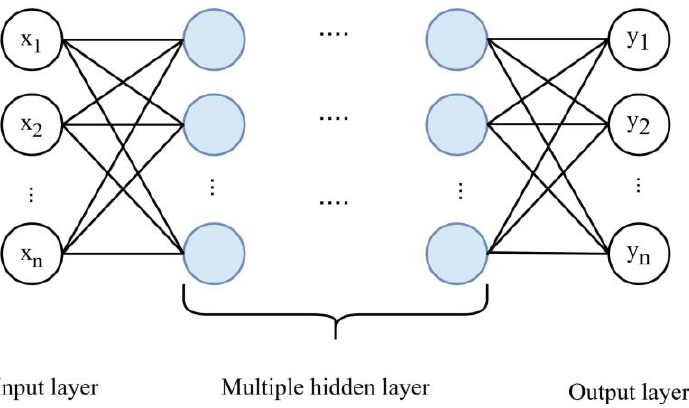
Figure 4. Architecture of DFCNN.